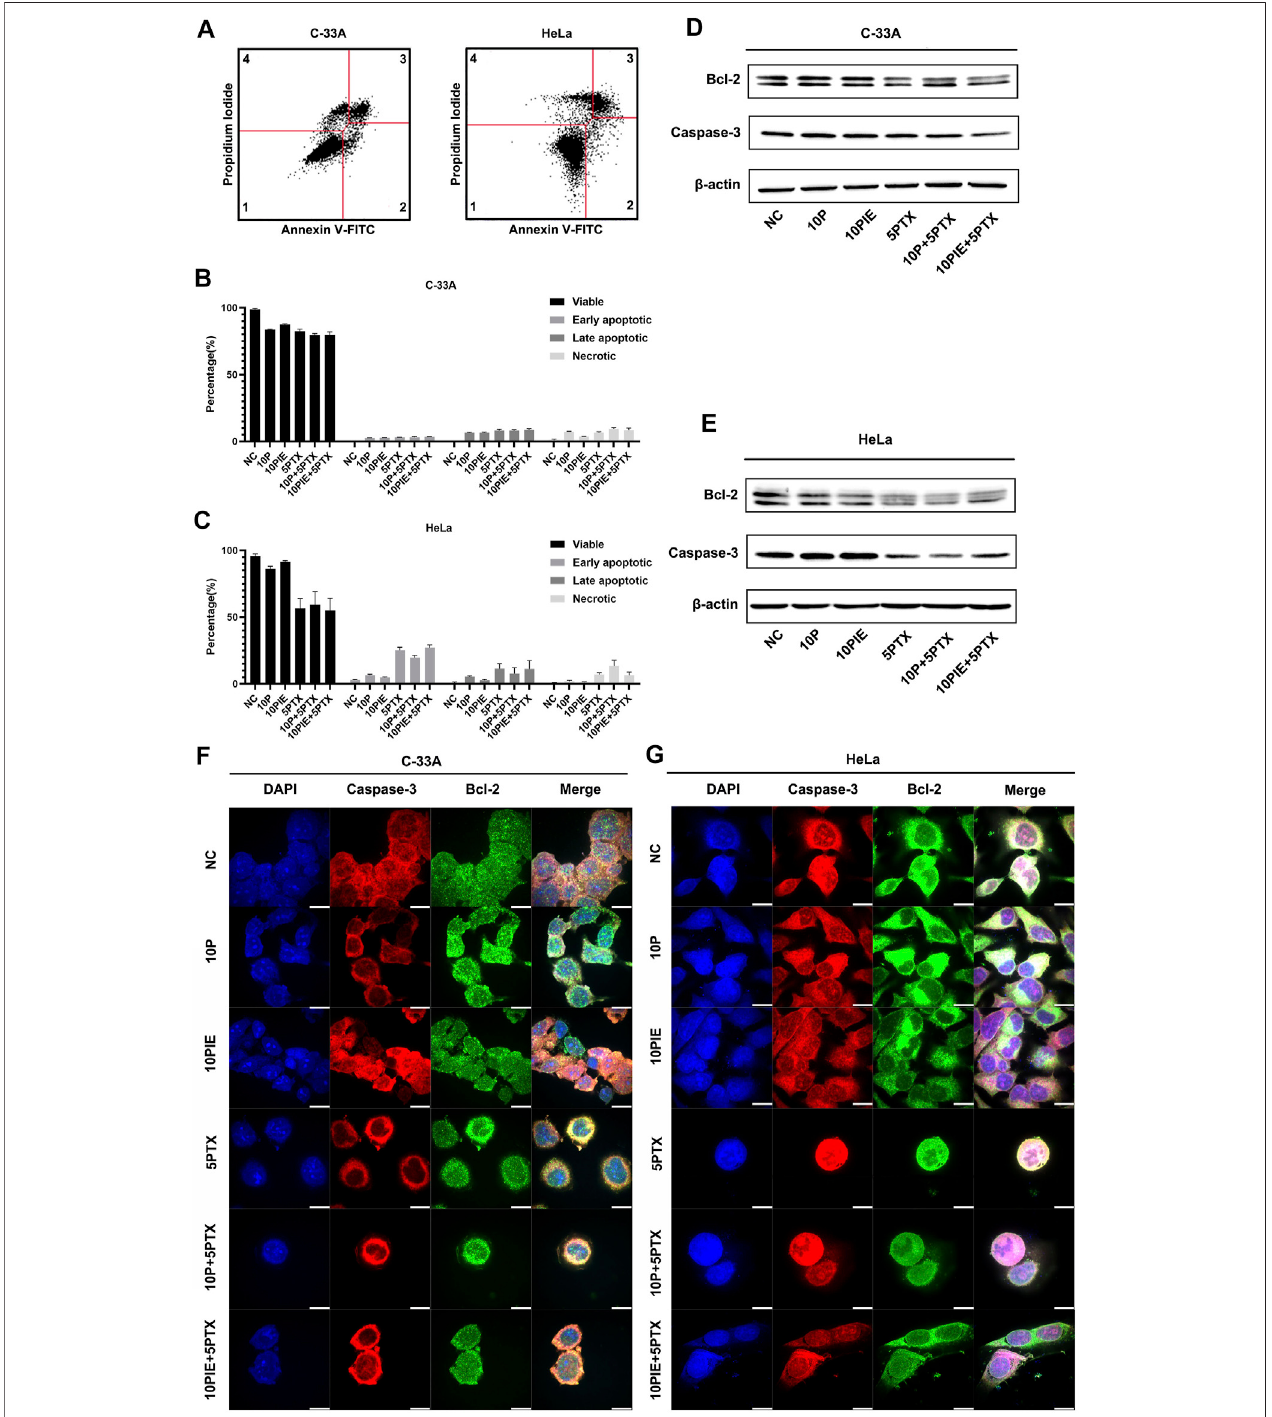
FIGURE2| EffectsofpropofolorPIEwithorwithoutpaclitaxeloncervicalcancercellapoptosis. (A) Gatingstrategyforcellapoptosisassessment.Representative plotswereobtainedfrom5 μ g/mlpaclitaxel-treatedC-33Acellsand5 μ g/mlpaclitaxel-treatedHeLacells. (B,C) Percentageofviable,earlyapoptotic,lateapoptotic,and necrotic C-33A and HeLa cells treated with propofol/PIE with or without paclitaxel. (D,E) The expression level of Bcl-2 and caspase-3 in C-33A and HeLa cells under treatmentofdifferentdrugcombinations. β -Actinwasusedastheinternalreference. (F,G) Theexpression andsubcellularlocalizationofBcl-2andcaspase-3inC- 33Aand HeLacells after treatment withdifferentdrug combinationswereindicatedbymIHC.DAPIwasused tostainthenuclei ofthecells. All thebars indicated 10 µm.